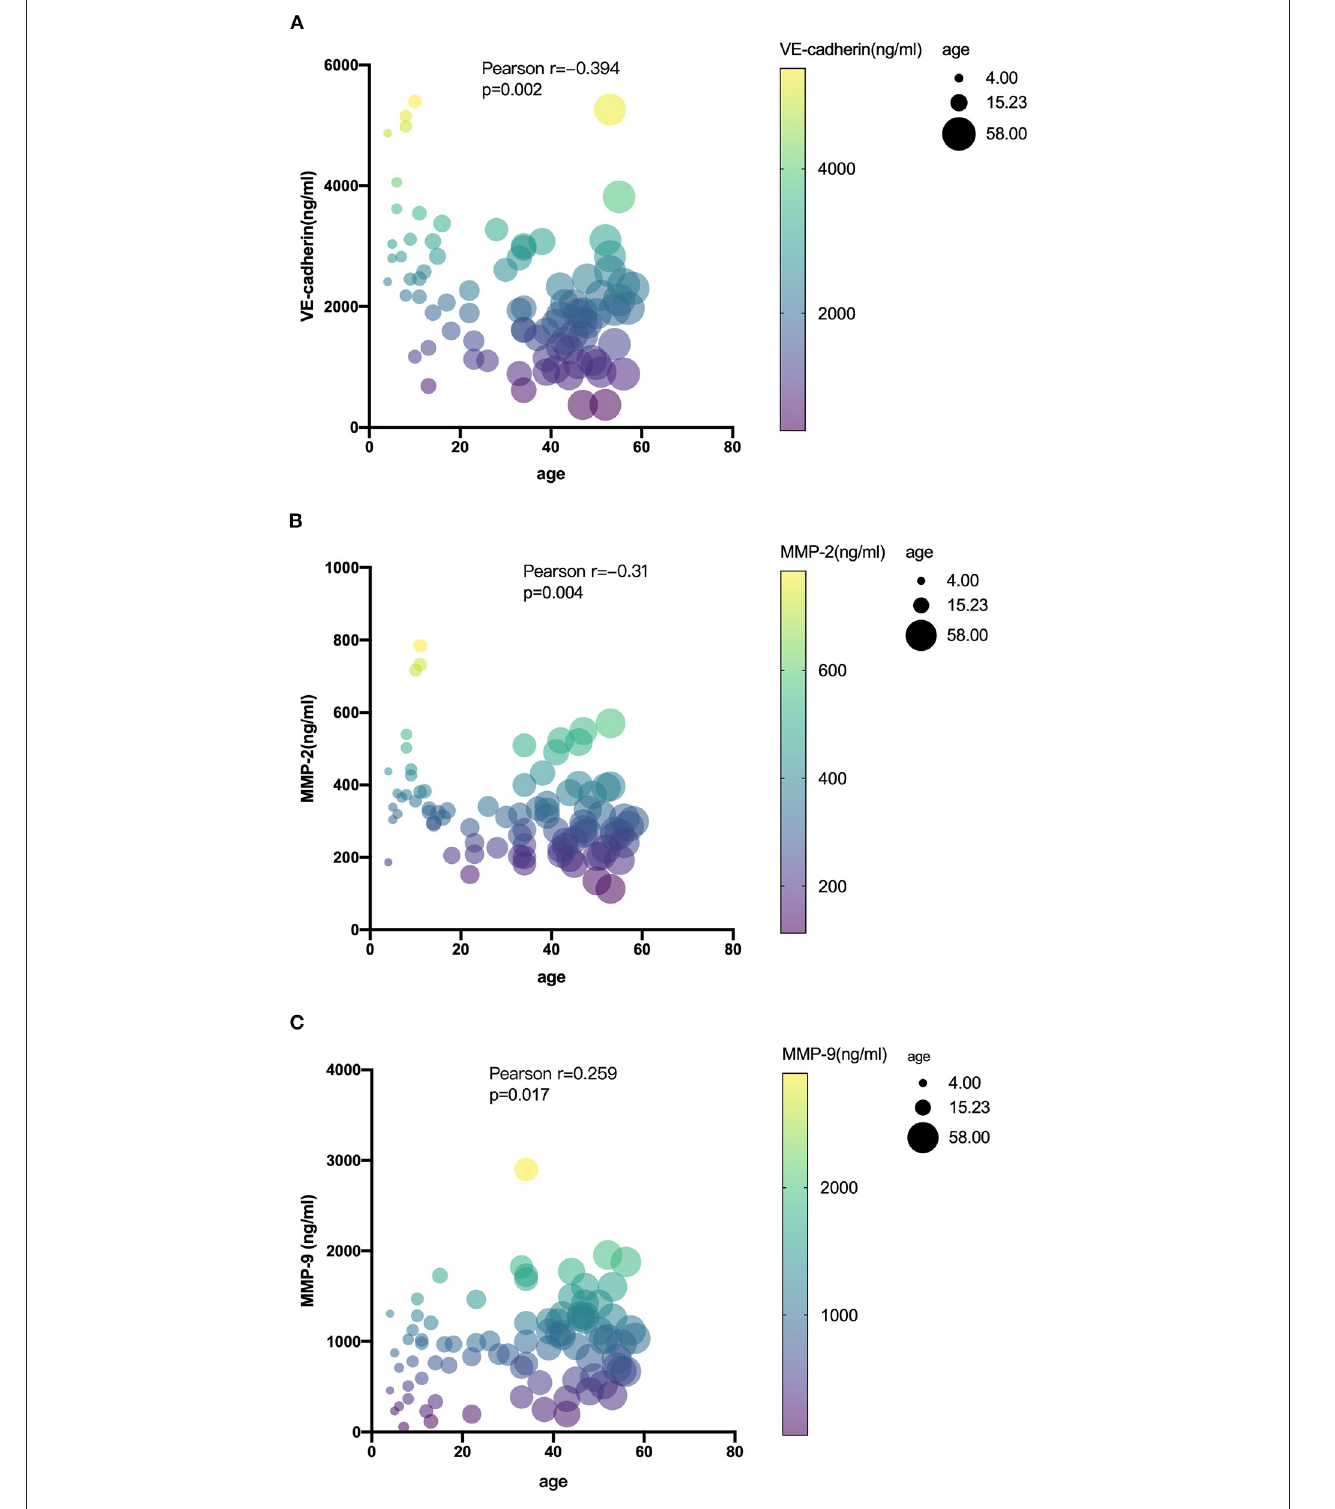
FIGURE 2 | Correlations among serum levels of VE-cadherin (A) , MMP-2 (B) , and MMP-9 (C) with age in MMD.